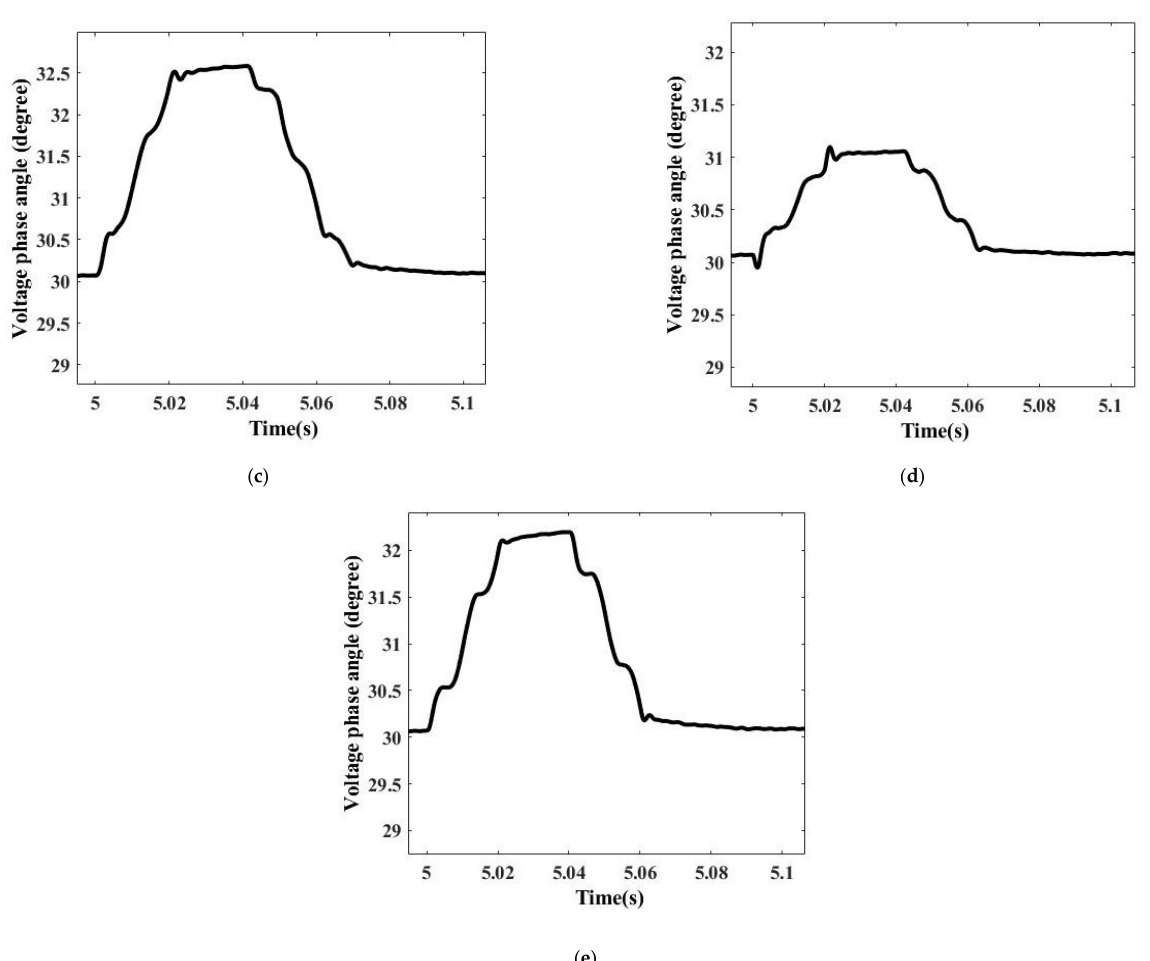
Figure 11. Magnitude of voltage phase angle during fault switching conditions ( a ) three-phase to ground (ABCG) fault ( b ) three-phase (ABC) fault ( c ) two-phase to ground (ABG) fault ( d ) AG one phase to ground (AG) fault ( e ) two-phase (AB) fault.